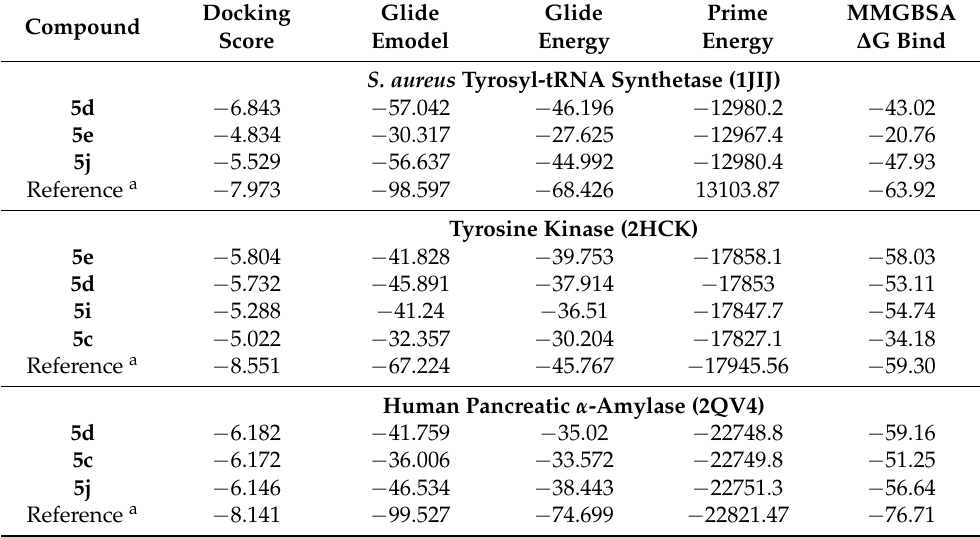
Table 5. Glide dock score and binding free energy of promising compounds with targeted